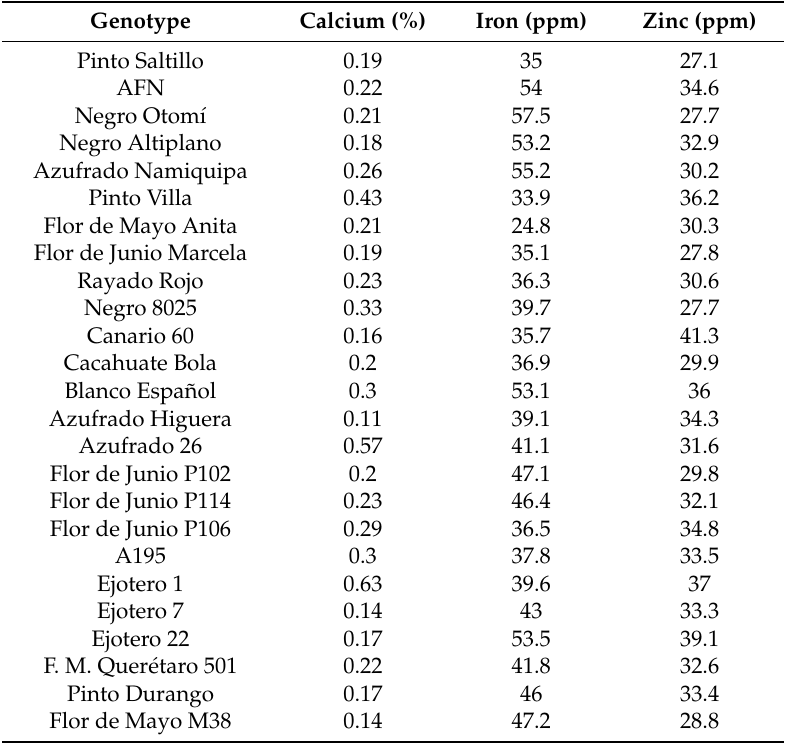
Table 6. Calcium, iron and zinc content on the seed of 25 enhanced genotypes of the Mexican common